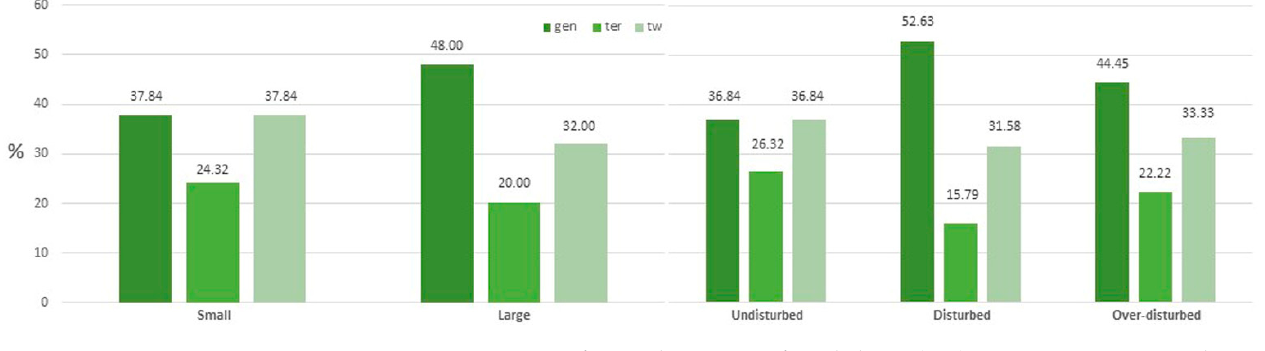
Figure 2. Percentage cover of generalist species of wet habitats (gen), opportunistic terrestrial species (ter), and specialist species of temporary pond (tw) in small and large SWEs ( left ), and in undisturbed, disturbed, and over-disturbed plots ( right ).